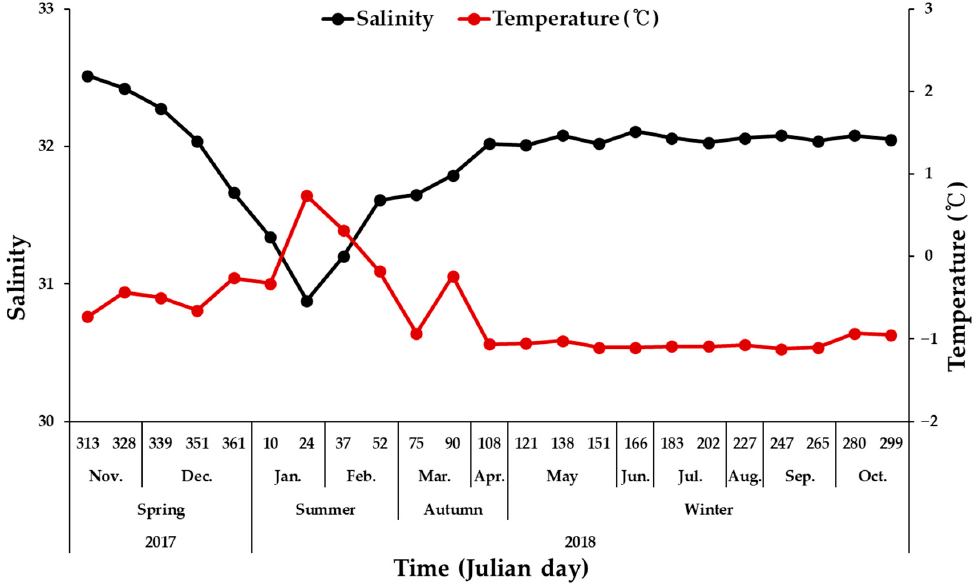
Figure 2. Salinity and temperature variations at the JBS during our sampling period.